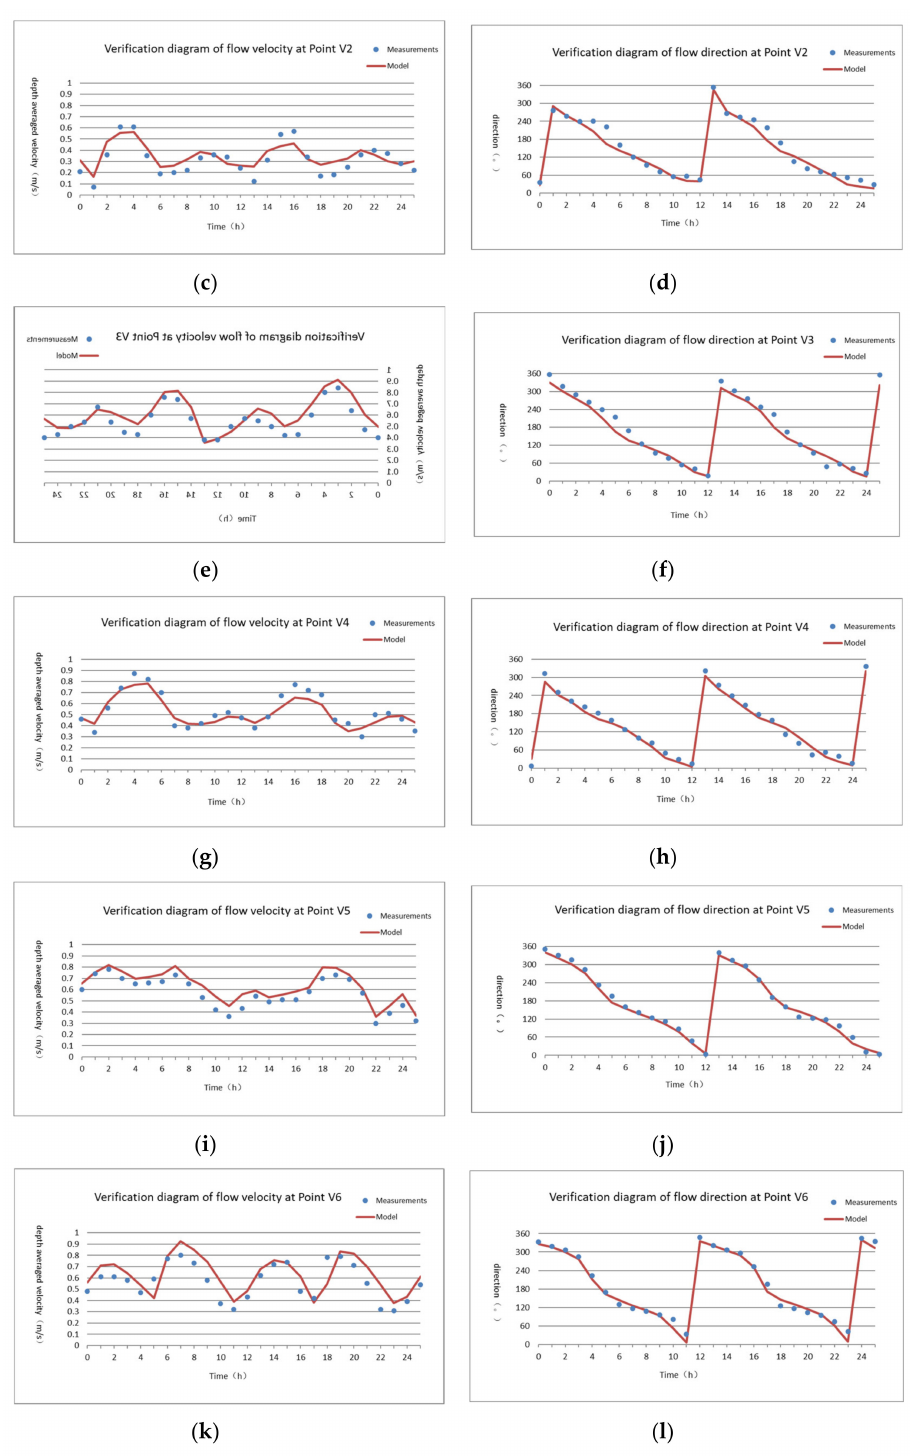
Figure 7. Tide current verification in 2016. ( a ) Verification diagram of flow velocity at Point V1; ( b ) Verification diagram of flow direction at Point V1; ( c ) Verification diagram of flow velocity at Point V2; ( d ) Verification diagram of flow direction at Point V2; ( e ) Verification diagram of flow velocity at Point V3; ( f ) Verification diagram of flow direction at Point V3; ( g ) Verification diagram of flow velocity at Point V4; ( h ) Verification diagram of flow direction at Point V4; ( i ) Verification diagram of flow velocity at Point V5; ( j ) Verification diagram of flow direction at Point V5; ( k ) Verification diagram of flow velocity at Point V6; ( l ) Verification diagram of flow direction at Point